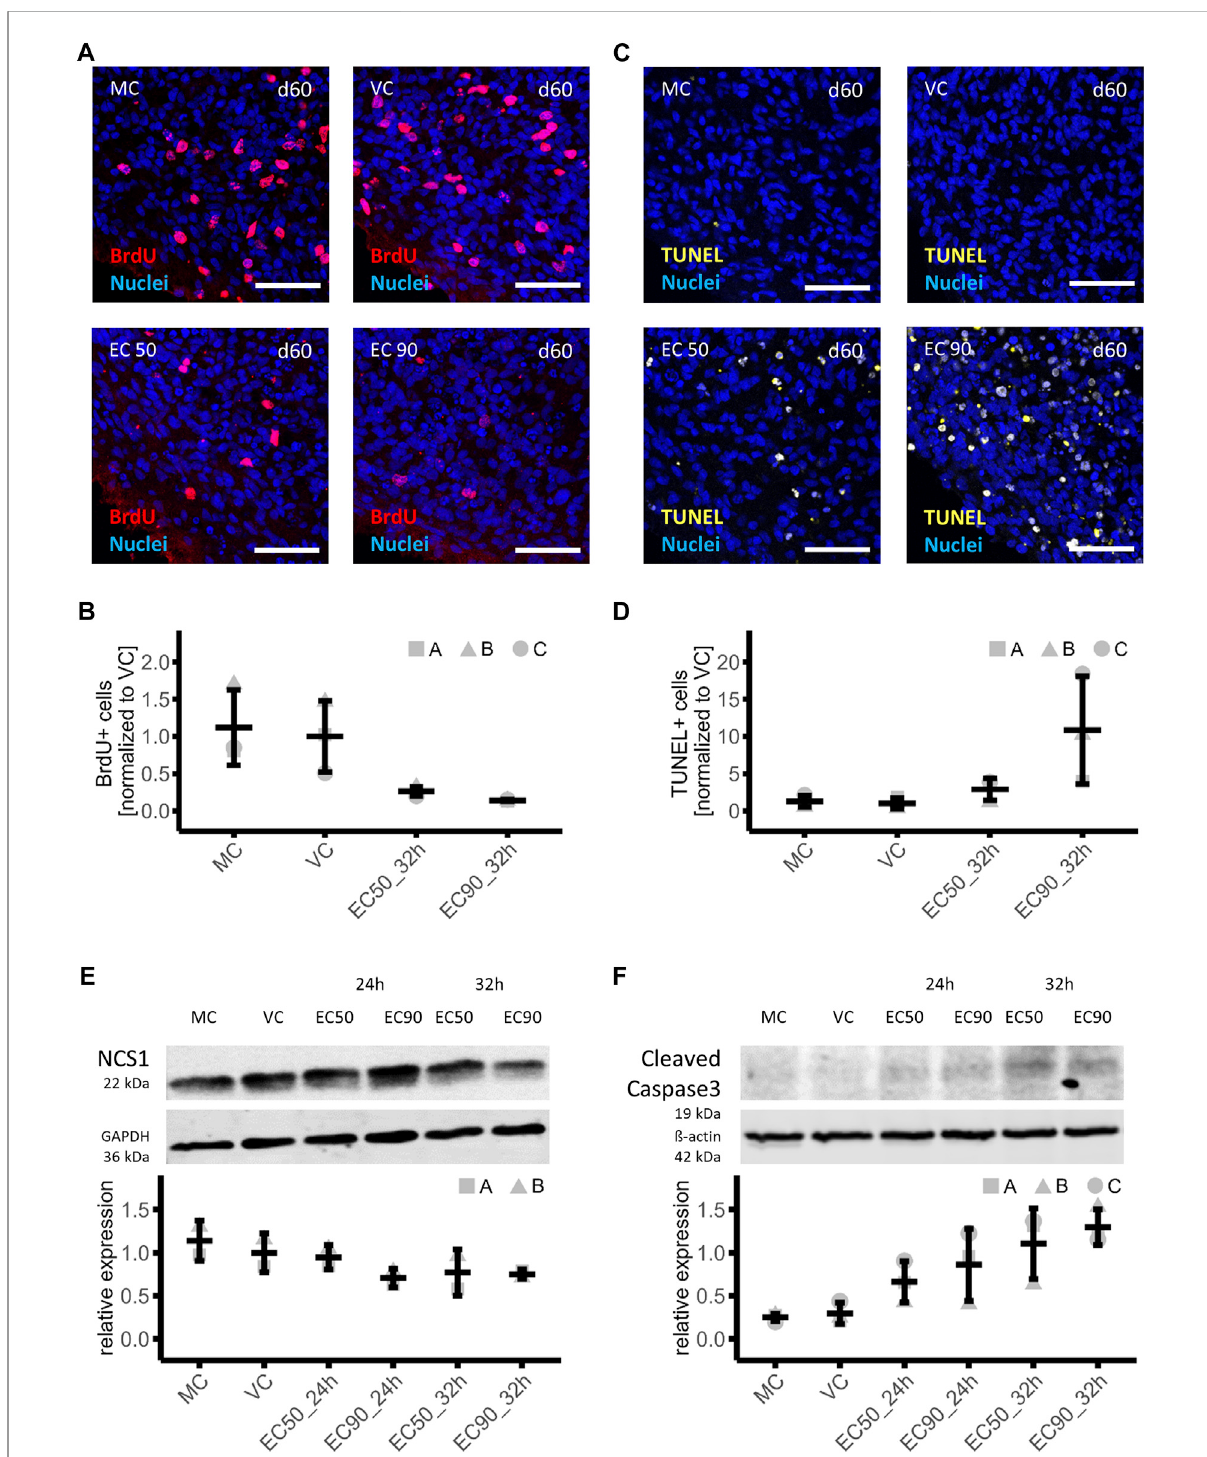
FIGURE 4 Effects of paclitaxel on cell proliferation, cell death and involved proteins in mature brain organoids. (A,B) Immunohistochemistry analyses of cell proliferation in brain organoids treated with paclitaxel (EC50: 153 nM and EC90: 1,084 nM) for 14 h with a subsequent culture in fresh media for 15 hand 3 hin BrdU containing medium (32 h sampling time point) or with medium (MC) or vehicle(VC) as controls (A) , demonstrated a74% or 86% lowernumberofBrdU+cellsinorganoidstreatedwithEC50orEC90respectivelycomparedtotheVC( n =3) (B) . (C,D) Analysisofapoptosisvia TUNEL assay in sections of the same brain organoids as used for proliferation assessment (C) showed a 2.9-fold and 10.9-fold increase in apoptotic